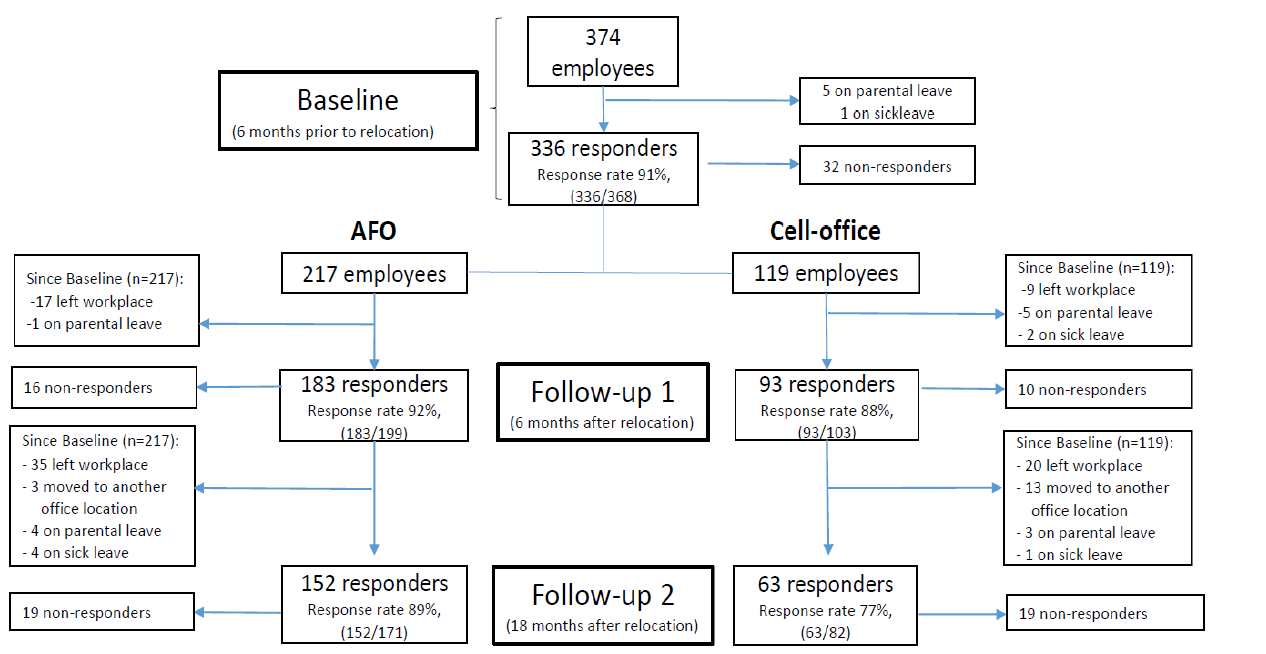
Figure 1. Flowchart of the original study population in total and at different time-points, including drop-outs.